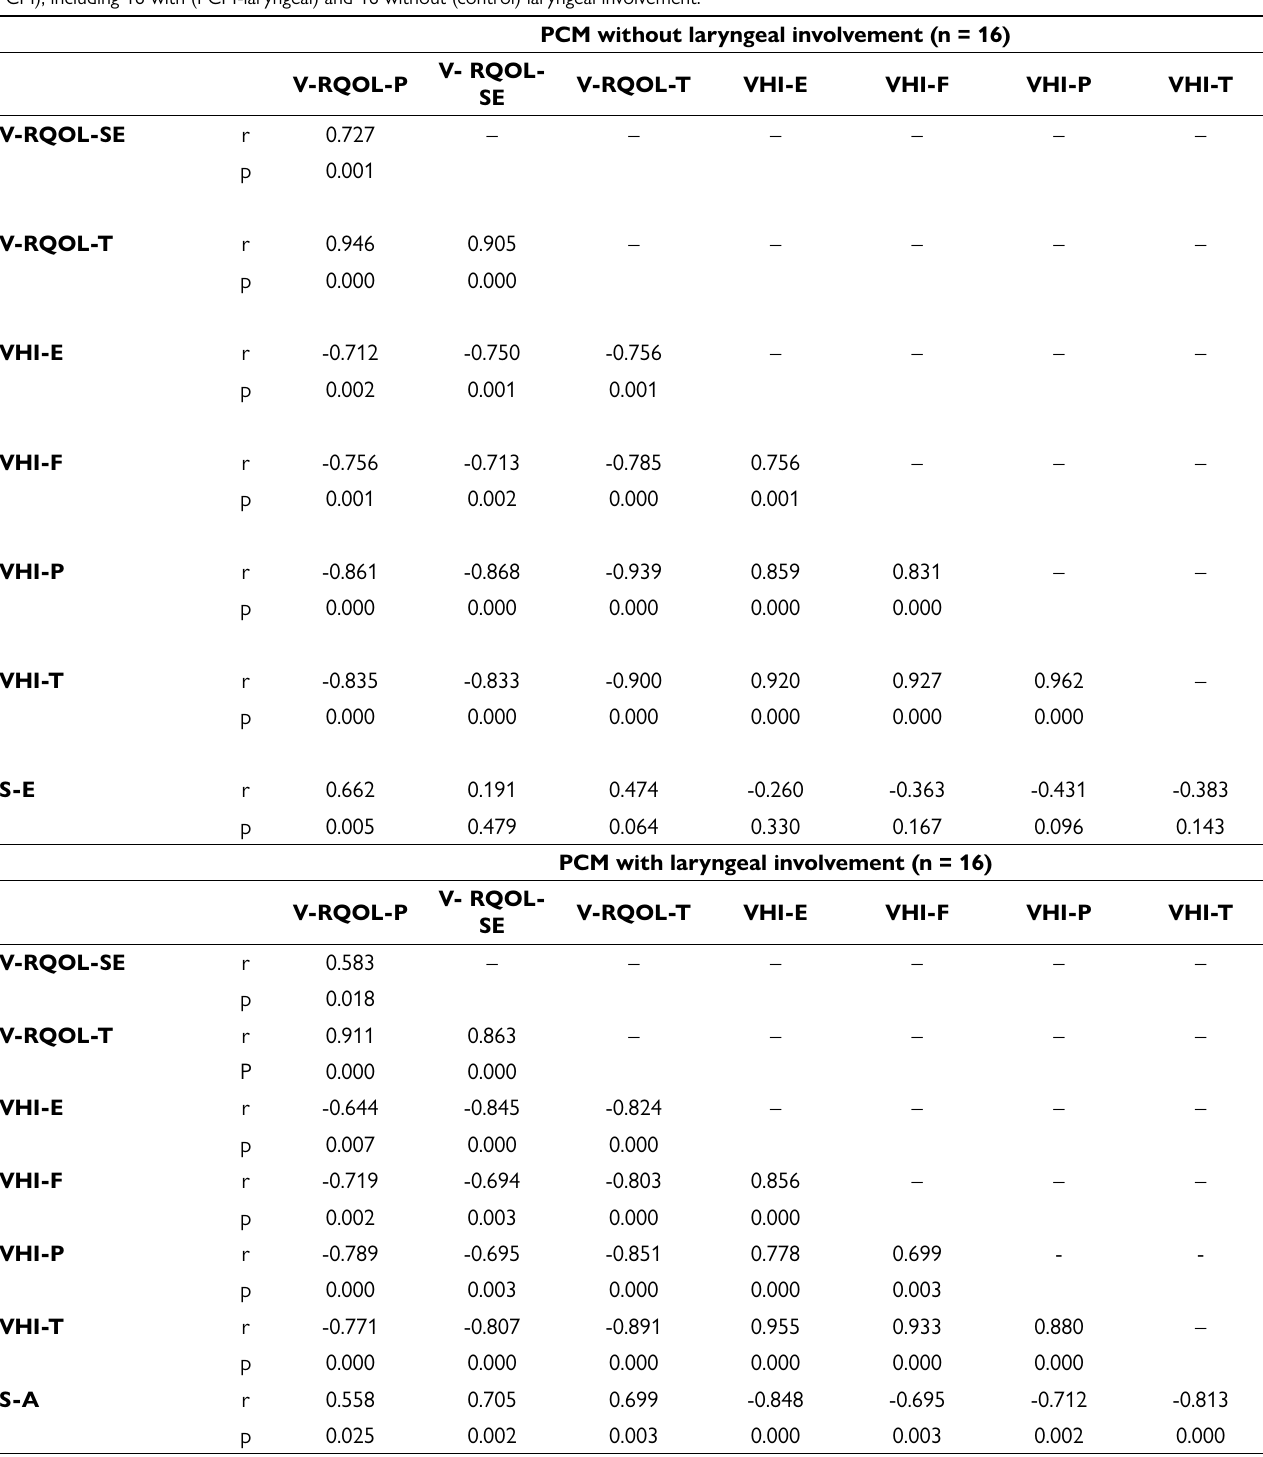
Table 3. Correlations among the V-RQOL and VHI questionnaires and self-assessment voice quality in the 32 patients with residual paracoccidioidomycosis (PCM), including 16 with (PCM-laryngeal) and 16 without (control) laryngeal